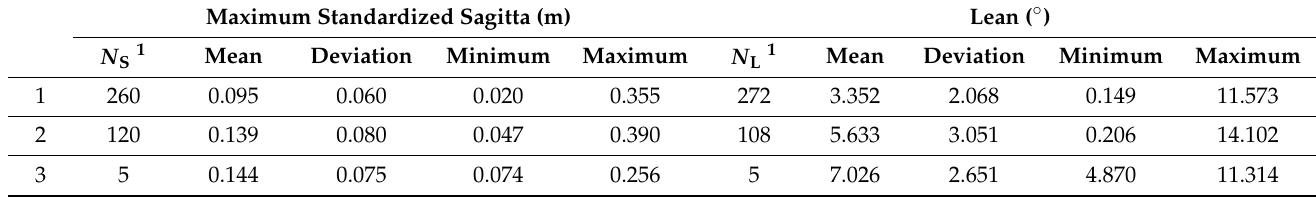
Table 3. Maximum standardized sagitta ( SS max ) and lean statistics obtained for the different categories shown in the probability density